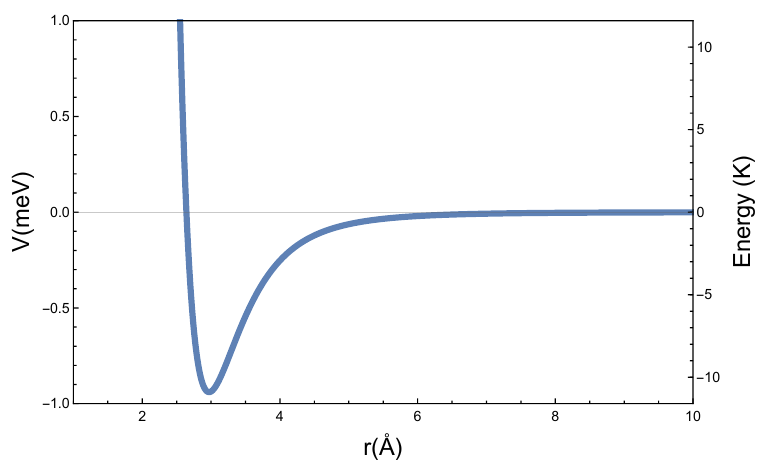
Figure 8 . Helium-helium atomic potential fitted from the experimental results in